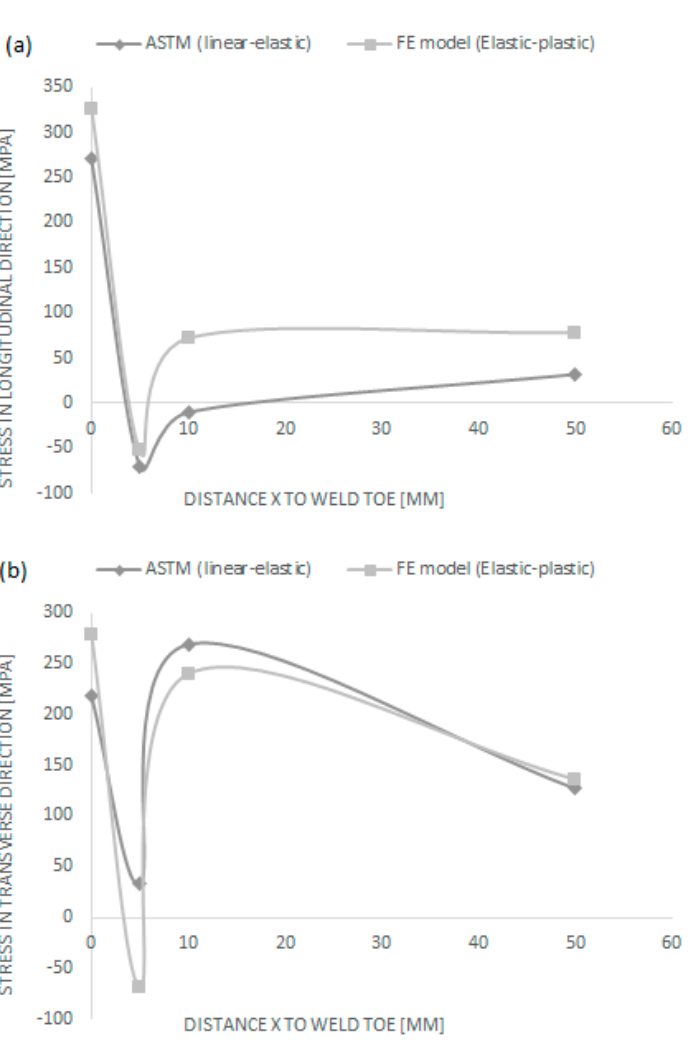
Figure 15. Comparison of residual stress distribution on the longitudinal stiffener between ASTM and the 3D model in the longitudinal ( a ) and transverse ( b ) directions.